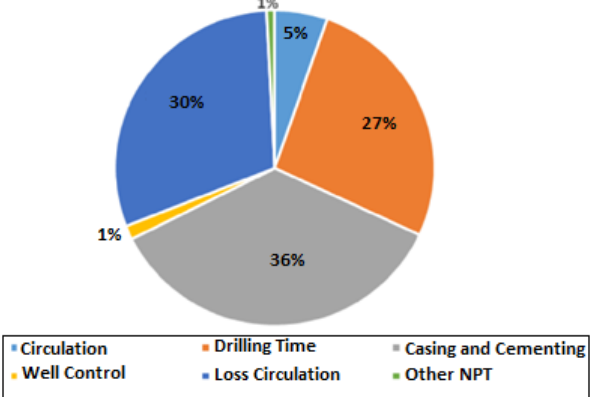
Figure 8. Operation time distribution for sample geothermal well in Indonesia [49].